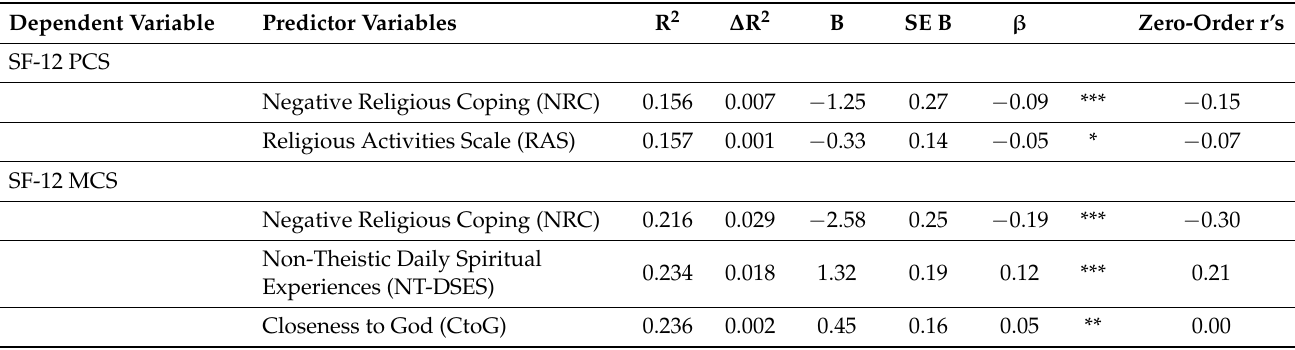
Table 6. Stepwise Multiple Regression Analyses using SS-1 Scales to Predict Physical and Mental Health Components of the